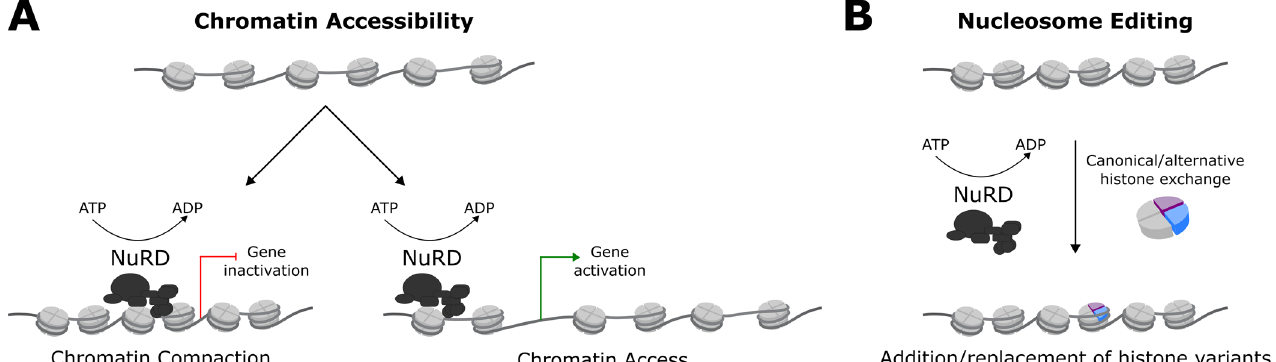
Figure 1. NuRD and nucleosome remodeling. ( A ) The ATPase/Helicase domain of Chd4 consists of two RecA-like lobes surrounding a DNA binding cleft and ATPase active site. This enzymatic domain uses a ‘twist defect’ mechanism to break histone-DNA contacts, resulting in a ~5 bp DNA translocation relative to the nucleosome [21,37]. DNA translocation regulates nucleosome spacing, thereby affecting chromatin access. Nucleosome sliding can lead to compaction or decompaction of the local chromatin environment, which can expose or occlude regulatory elements to alter the expression of target genes. During cerebellar development, NuRD suppresses the accessibility of regulatory elements, and decommissions a subset of promoters [29,38]. ( B ) Nucleosome remodeling can also facilitate the deposition of new histones and histone variants [39]. For a comprehensive view of nucleosome remodeler mechanisms, see [40].